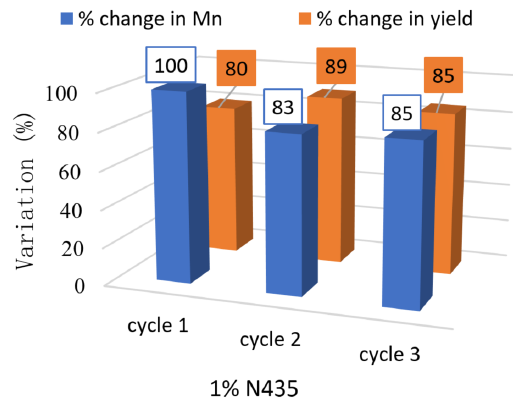
Figure 5. Effect of recycling 1% N435 on M n and yield in solution.